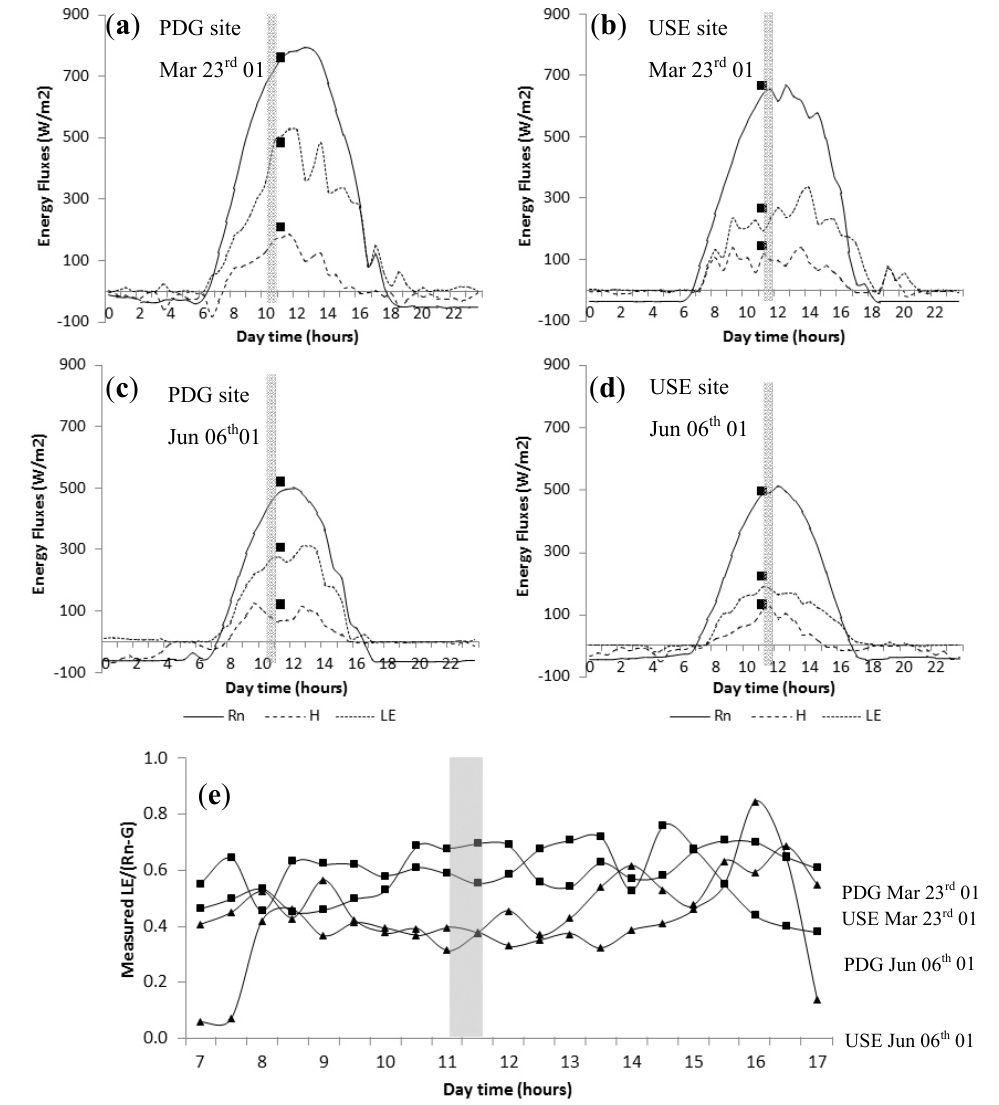
Figure 5. In situ measured energy fluxes (continuous and dotted lines) on 23 March 2001 (end of wet season) at PDG site ( a ) and USE site ( b ); and on 6 June 2001 (beginning of dry season) at PDG site ( c ) and USE site ( d ). Squares show instantaneous on-overpass (11:30am LT) energy fluxes estimated using SEBAL algorithm. Day-time variability of the evaporative fraction calculated from in situ measured data on those days ( e ). Shaded bars represent MODIS local overpass (11:30am